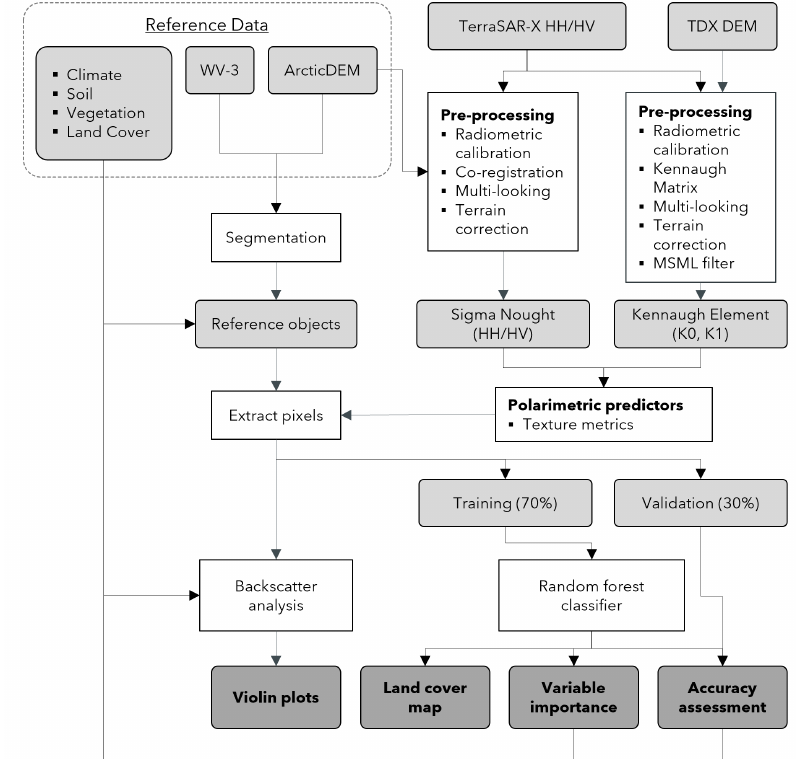
Figure 3. Workflow of Methods. The grey objects represent input and output data. The white squares represent the processing steps. MSML = Multi-looking